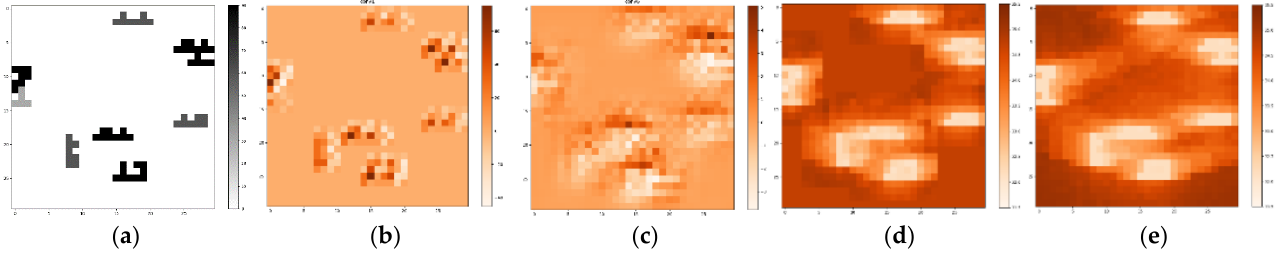
Figure 13. Comparison between typical hidden layer and calculation process of a random case in test dataset: ( a ) input matrix, ( b ) calculation data of convolution layer 1, ( c ) calculation data of convolution layer 6, ( d ) final prediction data, and ( e ) value calculated by Ladybug.